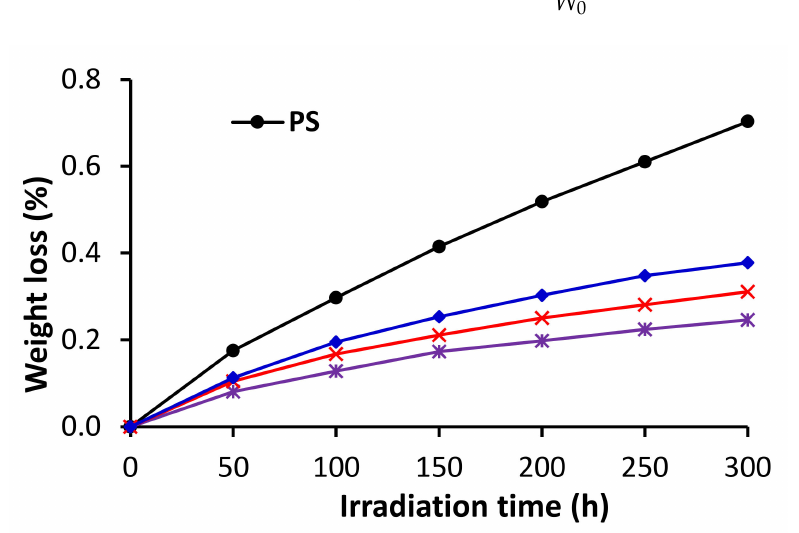
Figure 4. Weight loss (%) of PS films as a function of UV irradiation